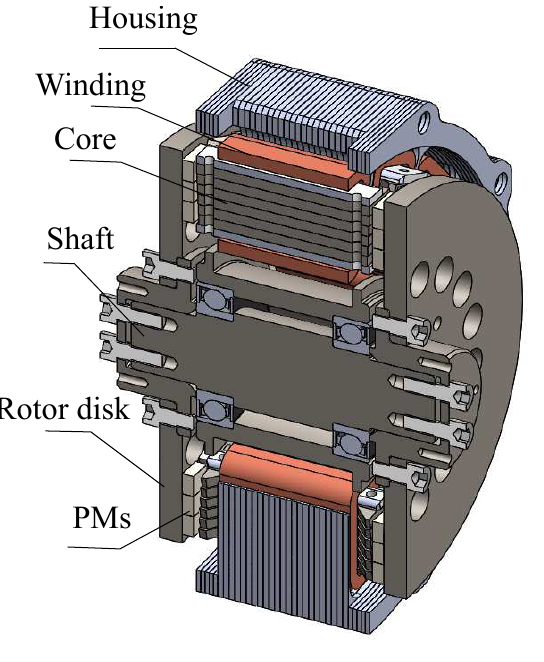
Figure 1. Cross-section view of the YASA